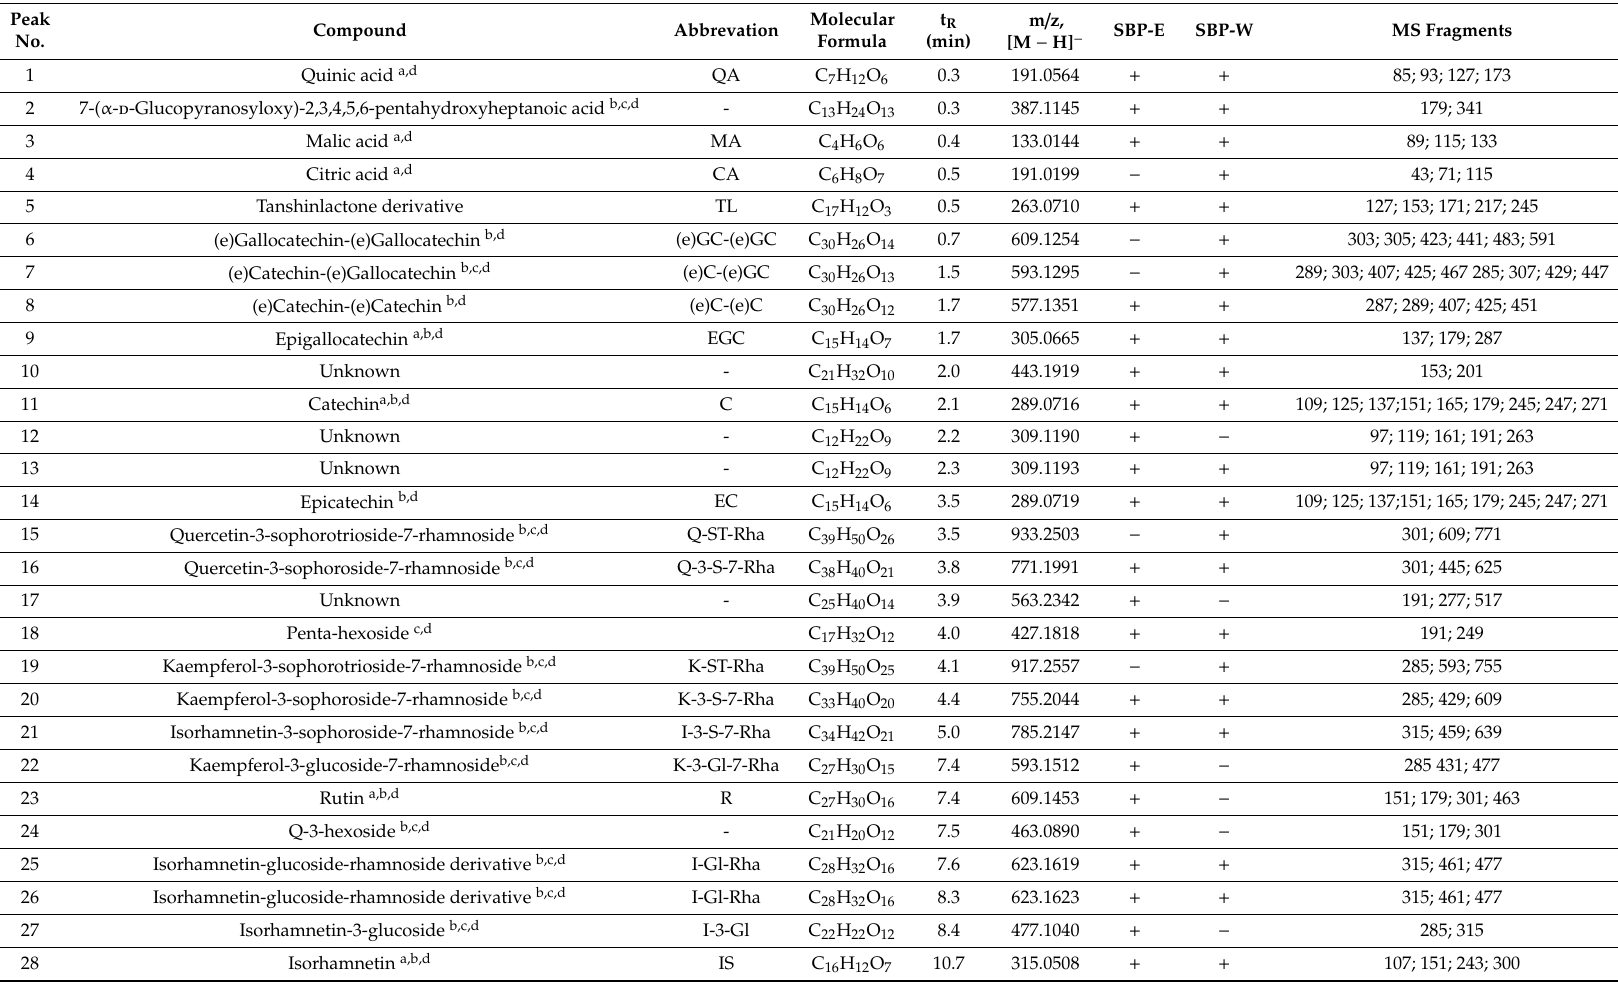
Table 2. Identification of phenolic compounds in SB pomace extracts by UPLC-Q / TOF. Peak